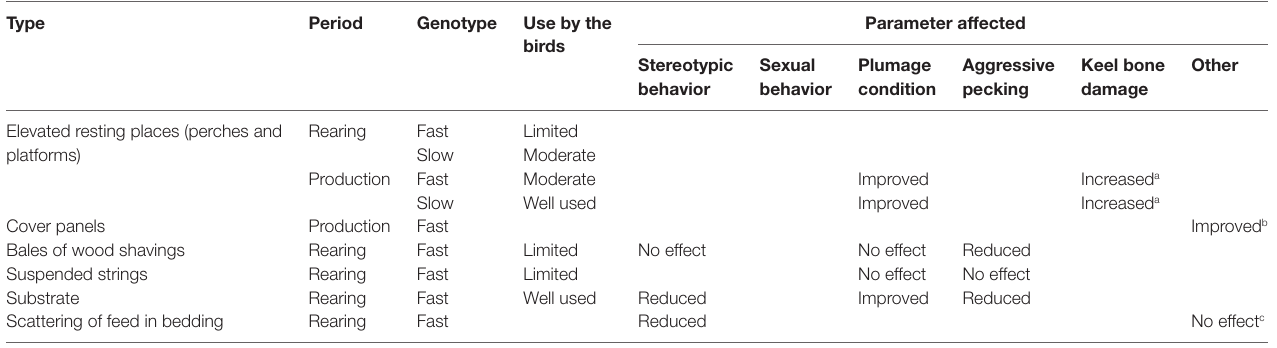
TABLe 2 | A summary of broiler breeders’ use of the different kinds of environmental enrichment reviewed in the present review and its effect on the prevalence of different welfare and production indicators measured. Type